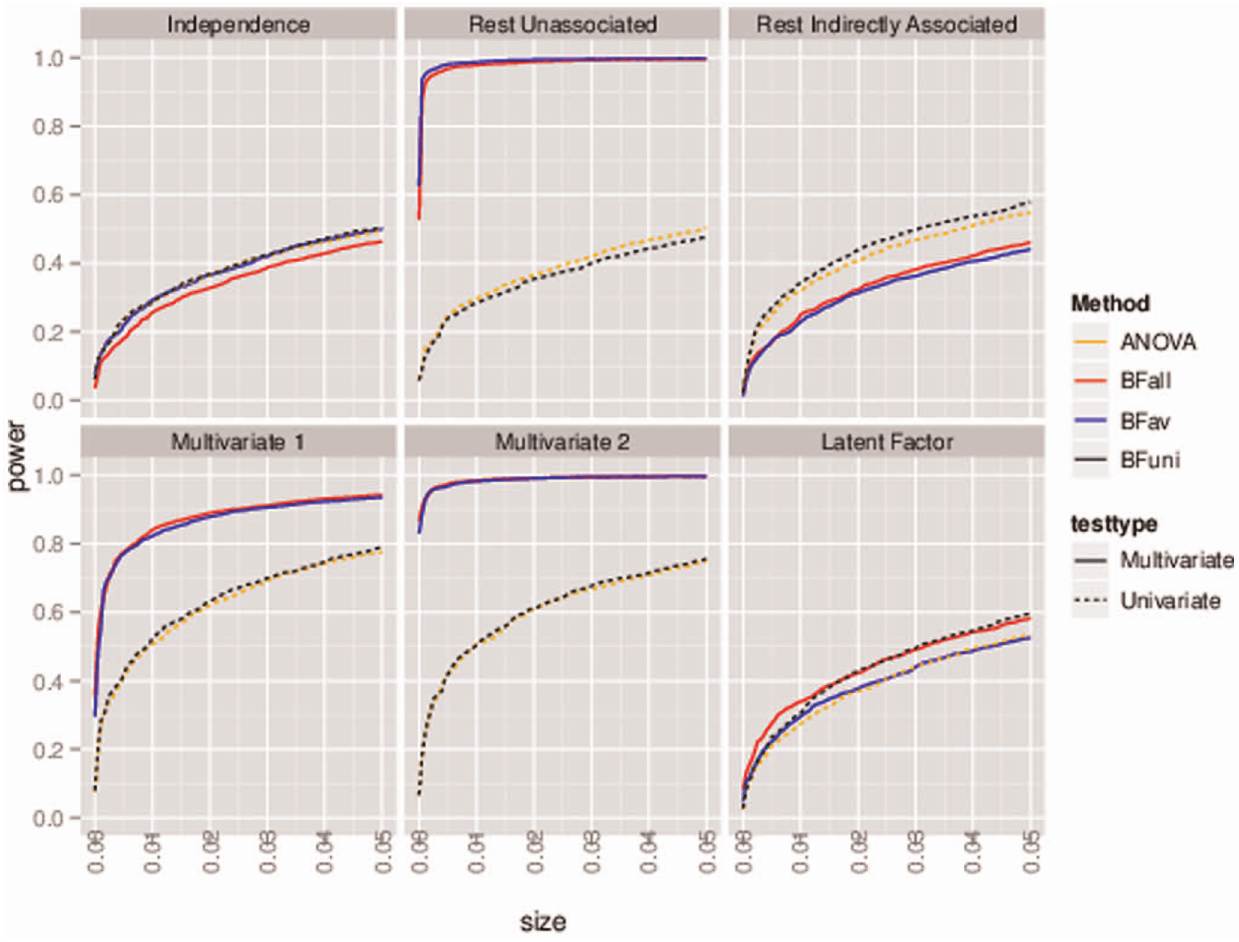
Figure 5. Power comparison of different test statistics under different simulated (five dimensional) multivariate scenarios. Each line shows the power vs size for a different test statistic; the univariate tests ( BF uni and ANOVA) are indicated by dotted lines. See main text for details of each simulation scenario and the test statistics compared.